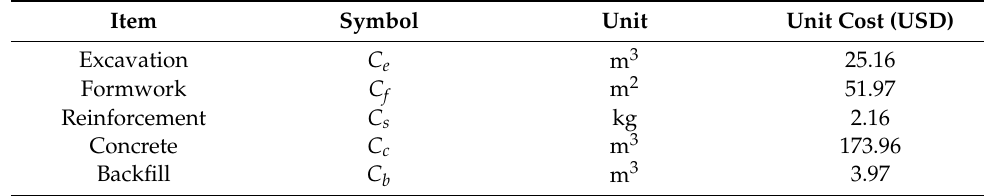
Table 7. Spread footing assembly unit cost